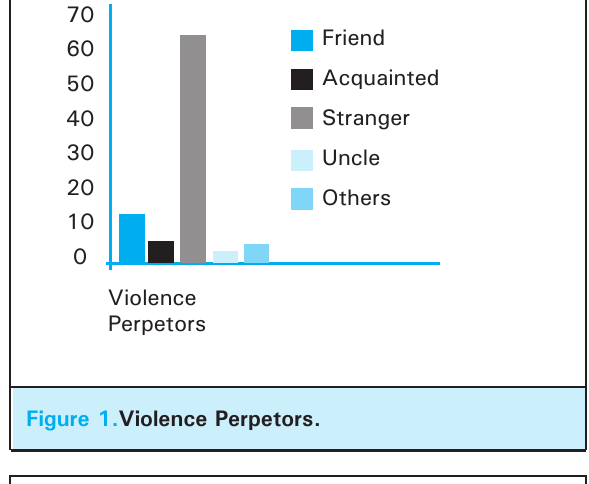
Figure 1.Violence Perpetors.